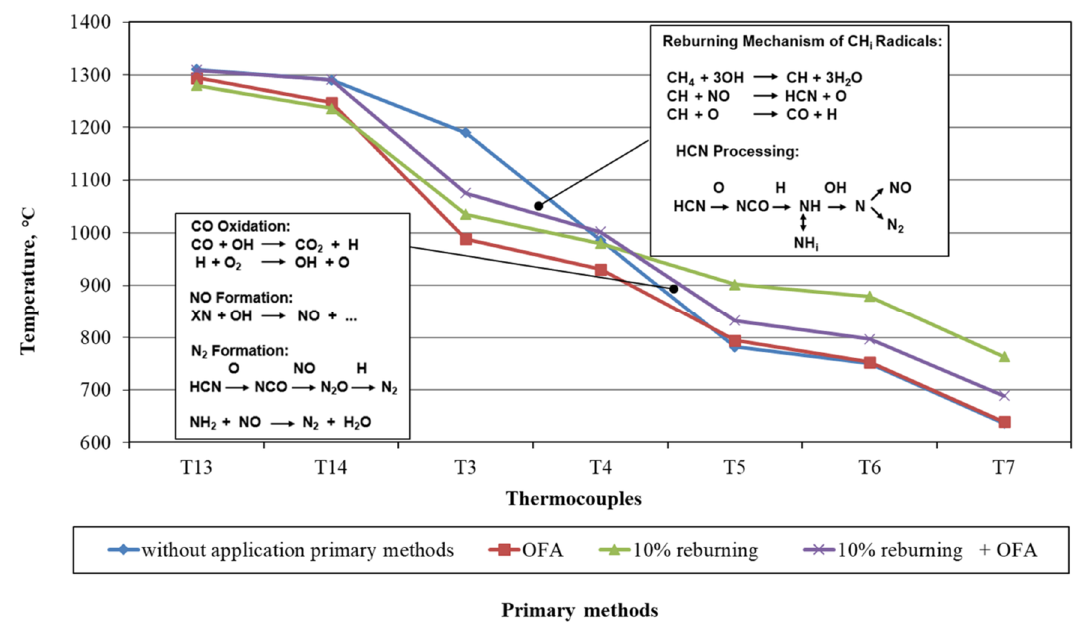
Figure 5. Measured flue-gas temperatures through the furnace during experiments involving fuel input Q = 1.5 m 3 / h and air excess coe ffi cient m = input Q = 1.5 m 3 /h and air excess coefficient m = 1.1.